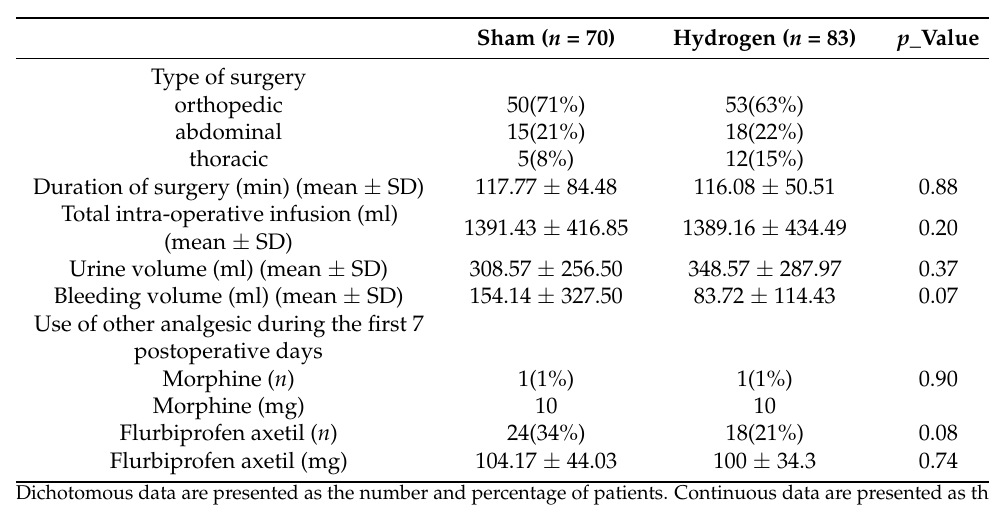
Table 2. Perioperative variables.